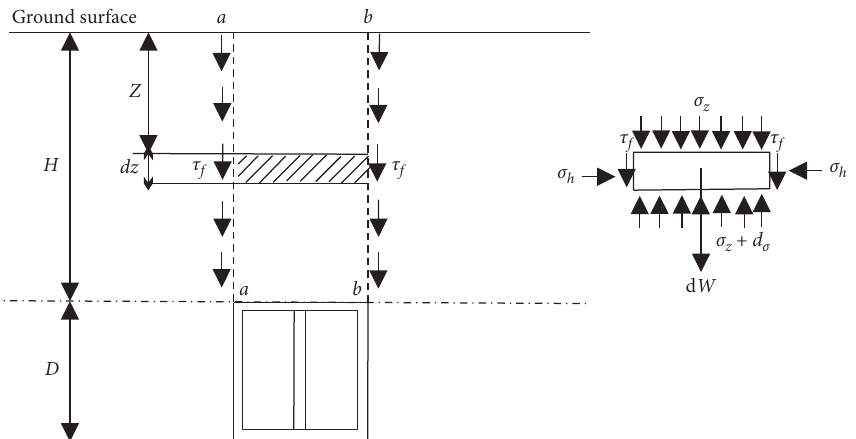
Figure 11: Calculation model of vertical earth pressure on the top of the utility tunnel in the hanging wall of ground